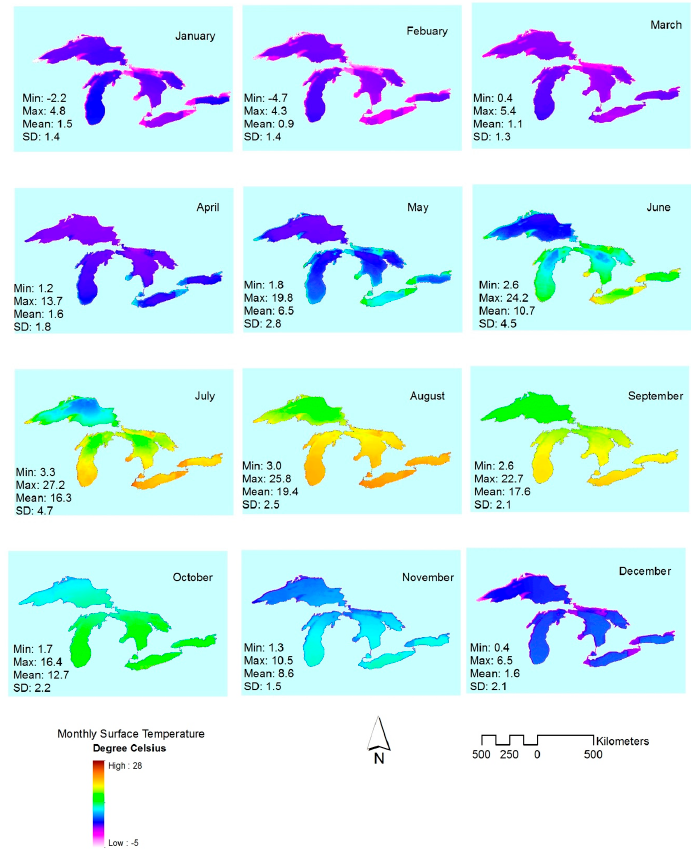
Figure 6. Spatial variation for monthly mean GLST (°C) from July 2001 to December 2014.